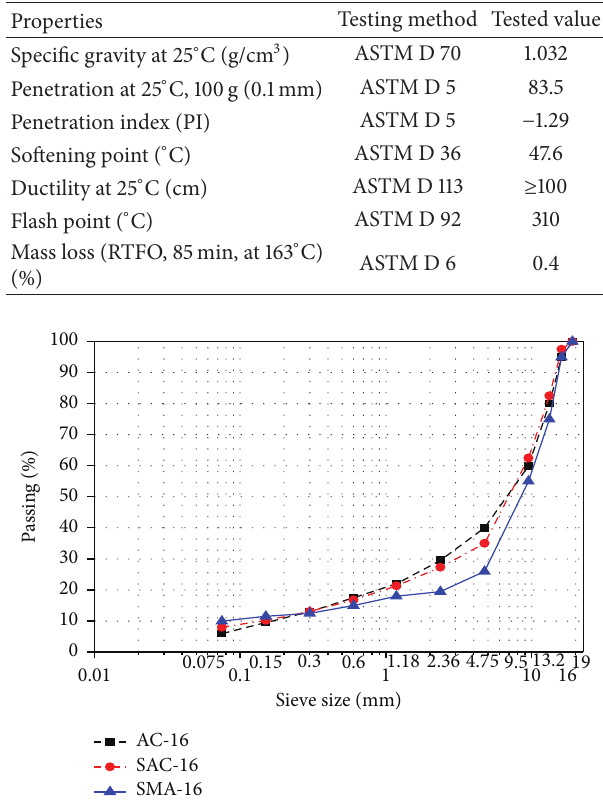
Table 2: Technical properties of the asphalt.